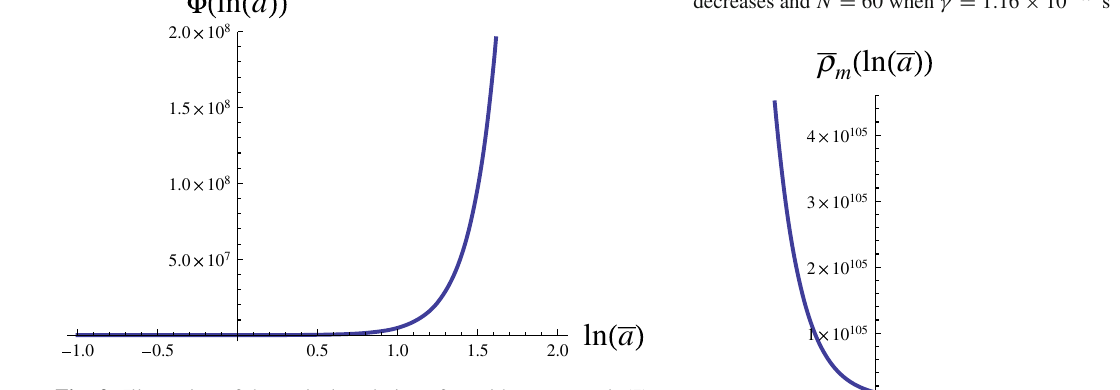
Fig. 2 Illustration of the typical evolution of (cid:17) with respect to ln ( ¯ a ) at the beginning of the inflation epoch. We assume that γ = 1 . 16 × 10 − 69 s 2 and ¯ a 0 = 1 at the beginning of the inflation epoch In the case of ¯ ρ m = 0, ¯ ρ (cid:17) is constant and the Friedmann